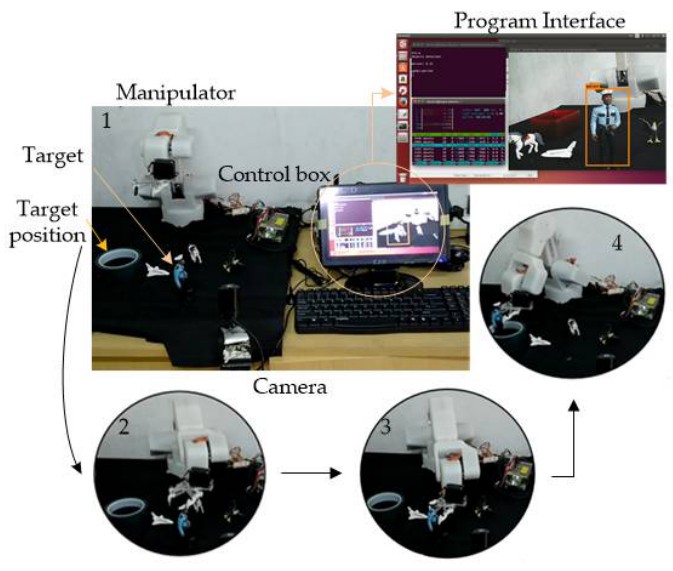
Figure 11 . Testing whole process of target object detection. Figure 11. Testing whole process of target object